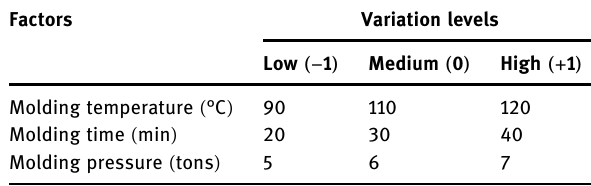
Table 5: Parameters for experimental